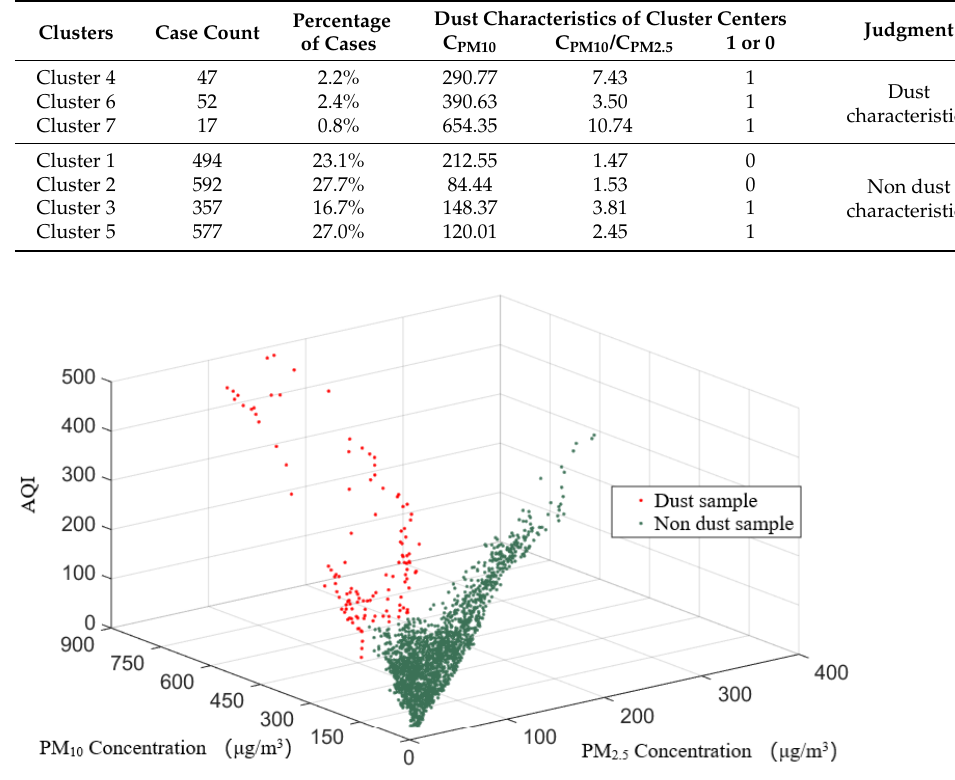
Figure 4. Dust samples identified by MDPD-k-means algorithm.